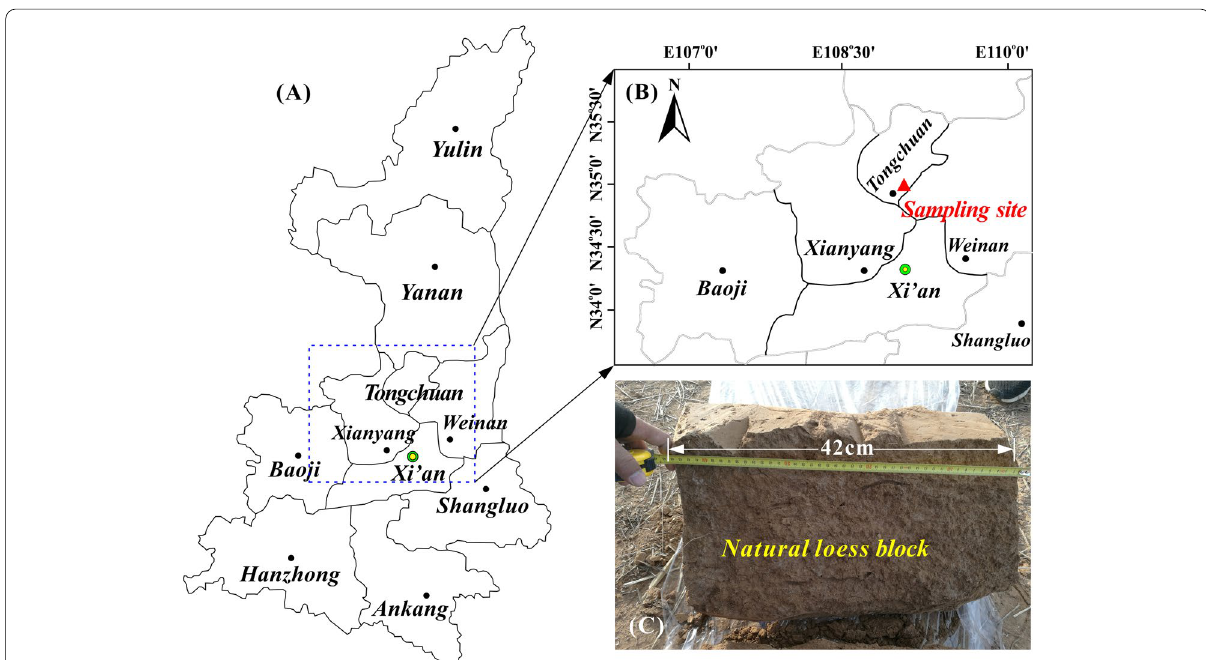
Fig. 1 Details of the sampling site. A , B Geographical location of the sampling area; C natural loess block